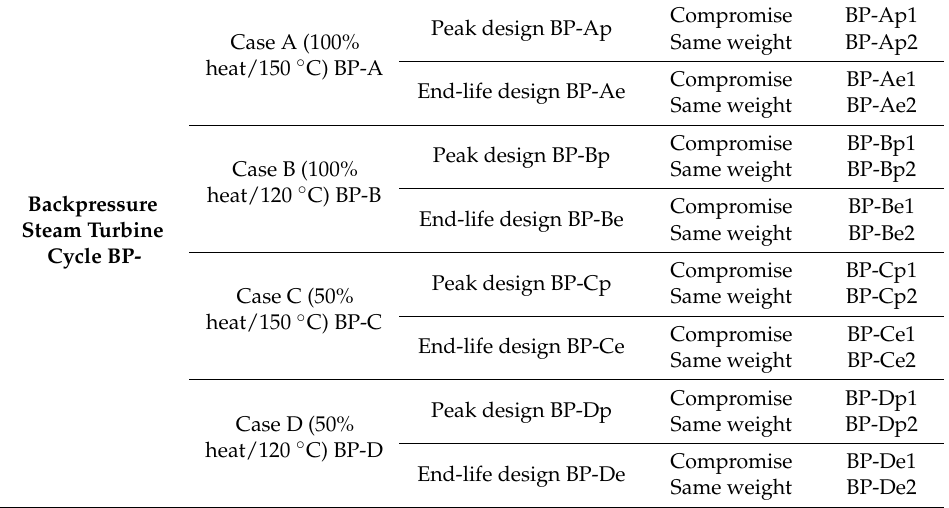
Table 3. Overview of all the designs defined for the backpressure steam turbine